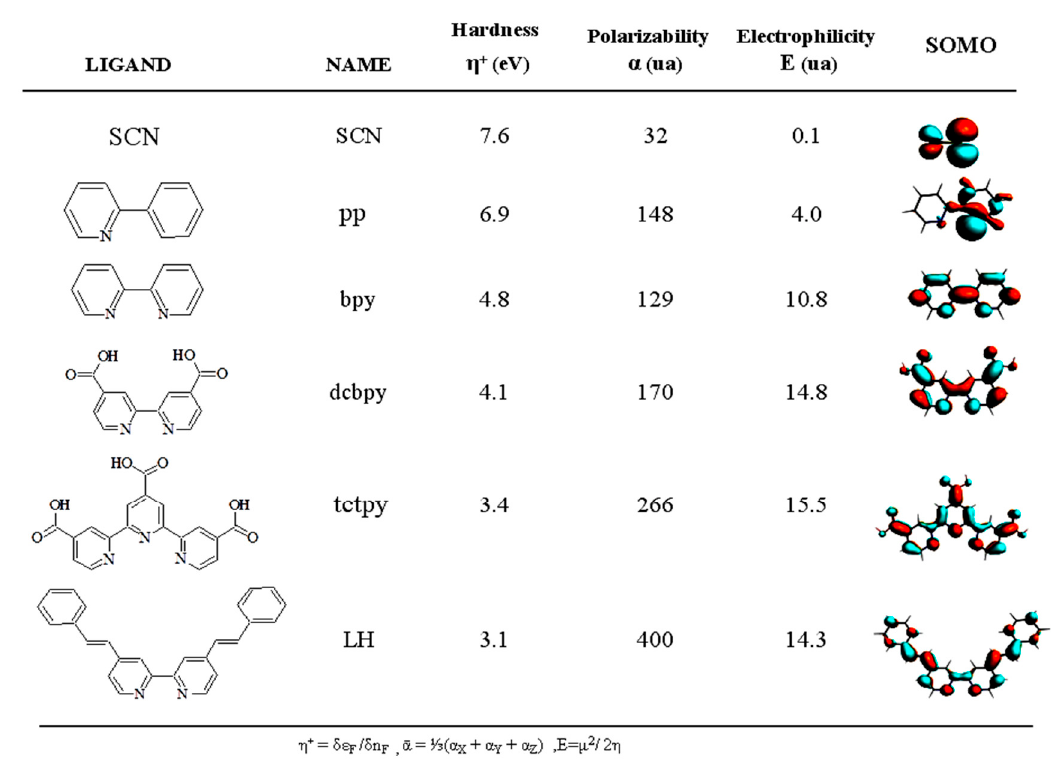
Figure 27. Comparison of calculated properties for different types of Ligands.